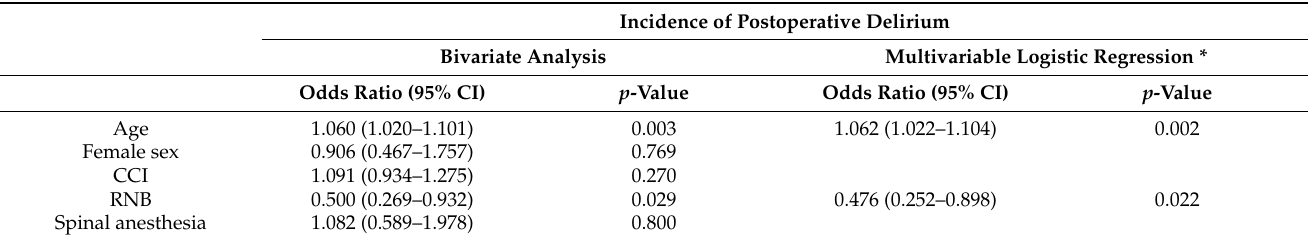
Table 6. Bivariate and multivariable logistic regression analysis for the risk factors of postoperative